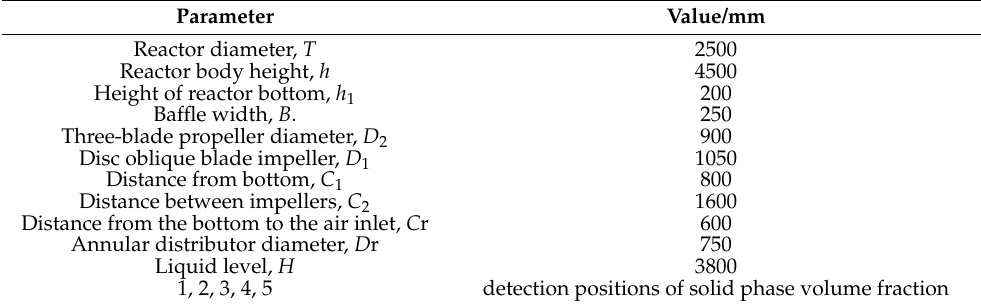
Table 1. Geometric parameters of industrial scale mixing stirred reactor.